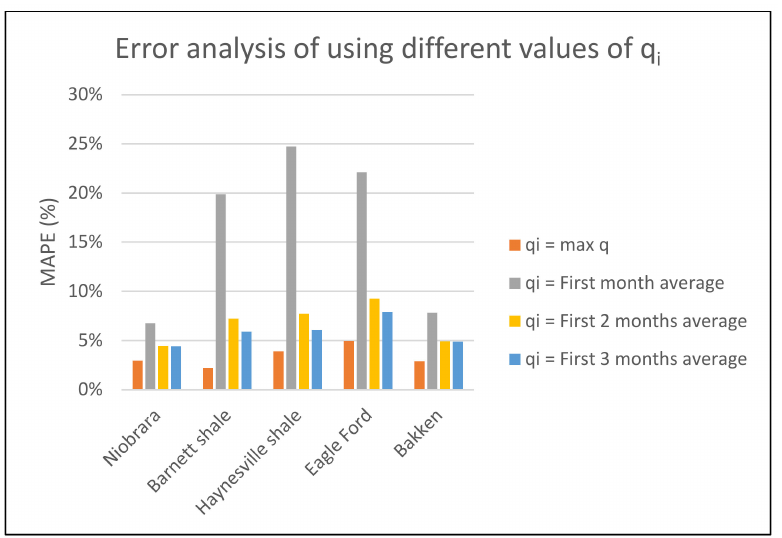
Figure 10. Average MAPE of using four different values of initial flow rate definitions (q i ) for all wells in each formation in calculating estimated ultimate recovery (EUR) using the SEPD model. Table 7. MAPE (%) of using different initial flow rate values in production history matching using the SEPD model. MAPE Formation